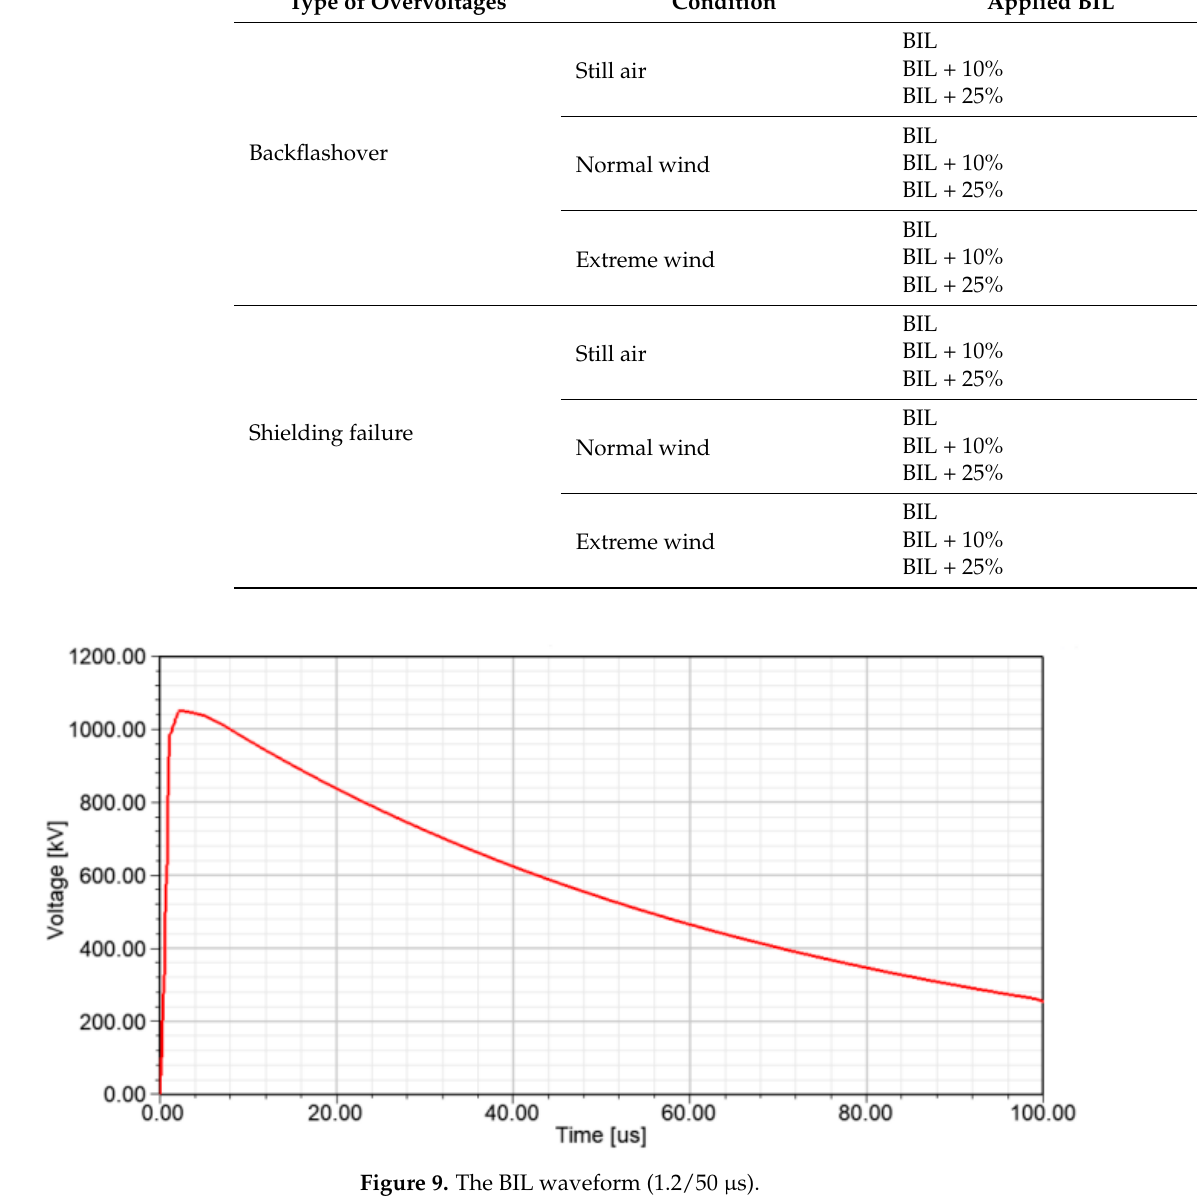
Figure 9. The BIL waveform (1.2/50 µs).